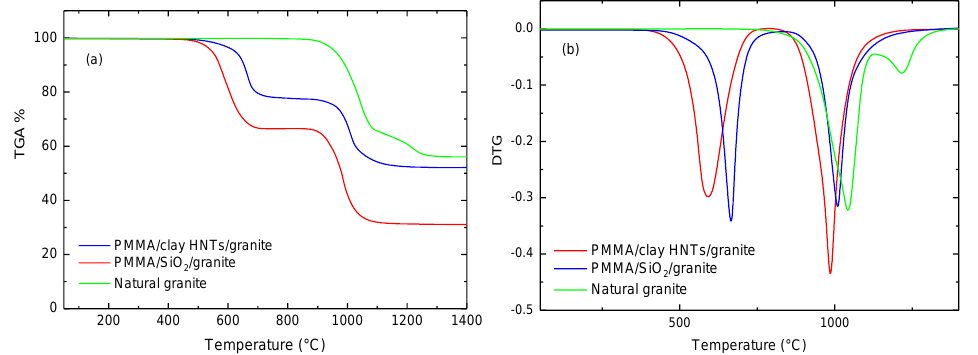
Figure 10. Effect of nanofiller type on TGA ( a ) and DTG ( b ) curves of Basalt solid surface nanocomposites (compared to natural basalt).